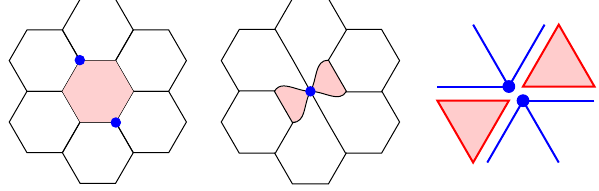
FIG. 1. Left and middle: merging inside a hexagonal lattice. After merging, the resulting vertex has degree 6. Note that the surrounding faces are unaffected (besides being deformed). Right: after merging we can break the X check (blue) and Z check (red) into two pairs of operators. These operators all have weight 3. Operators of different types pairwise anticommute, but they commute with all remaining stabilizers in the lattice.